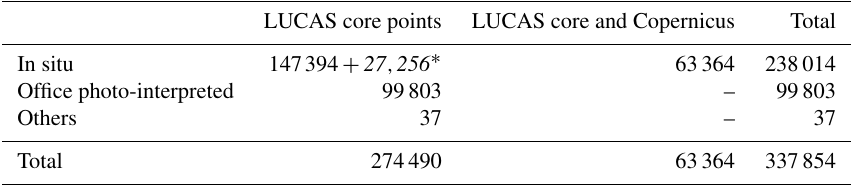
Table 1. LUCAS 2018 points totaling 337854 points. The points were either surveyed in situ (238014, 70.45%), photo-interpreted in the office (99803, 29.54%), or not surveyed (i.e., “in situ PI not possible”, “out of national territory”, or “out of EU28”). The Copernicus module was collected for a subset of the in situ points in addition to the LUCAS core protocol collected for any in situ point.